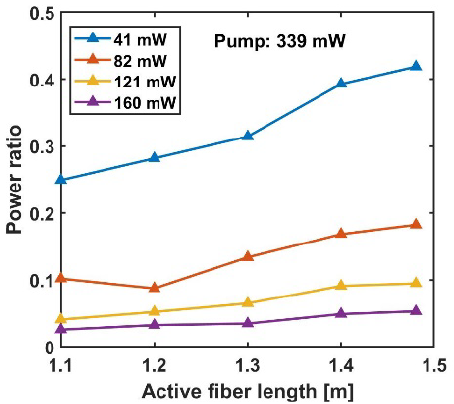
Figure 8. The variation in power ratio with active fiber length.